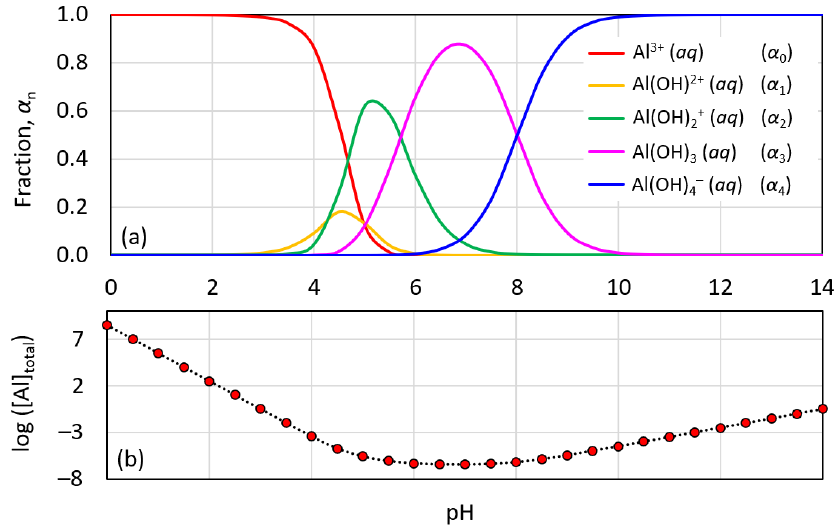
Figure 6. Dependence of reaction solution pH on Al NP mass